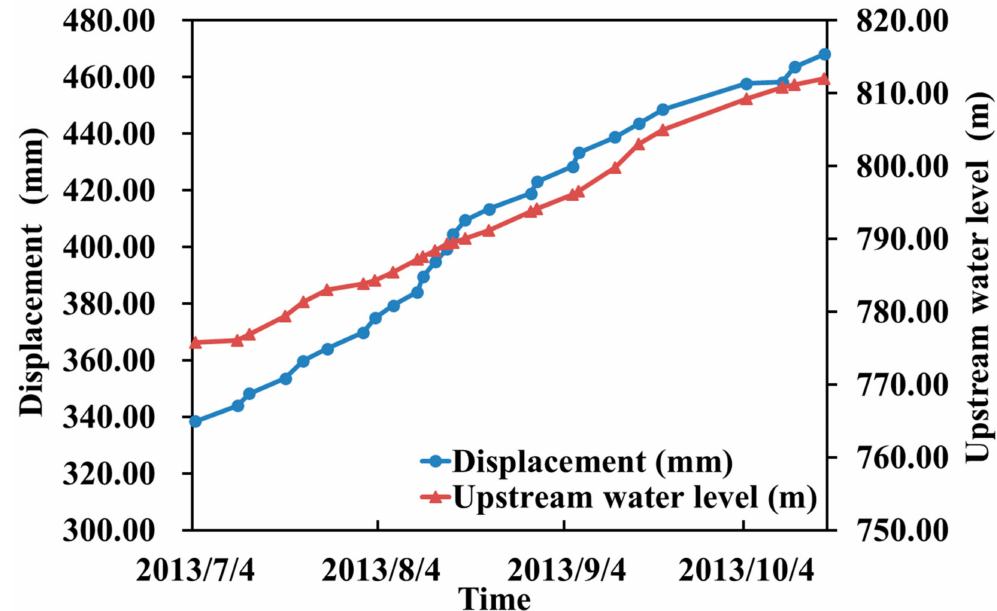
Figure 8. Process line between displacement and upstream water level. During the initial impoundment, the displacement increased with the upstream water level and time.